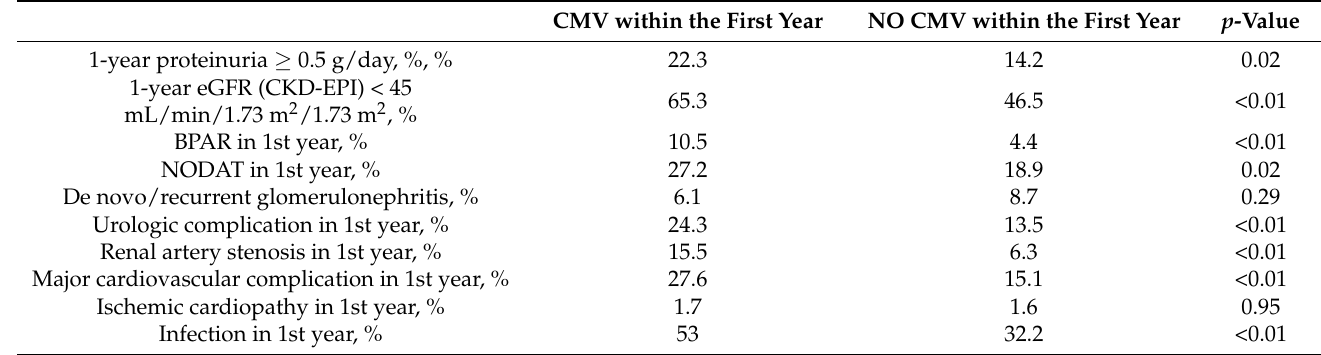
Table 2. Post-transplant complications, renal function, and proteinuria in patients with or without CMV replication/disease in the first year after transplantation.